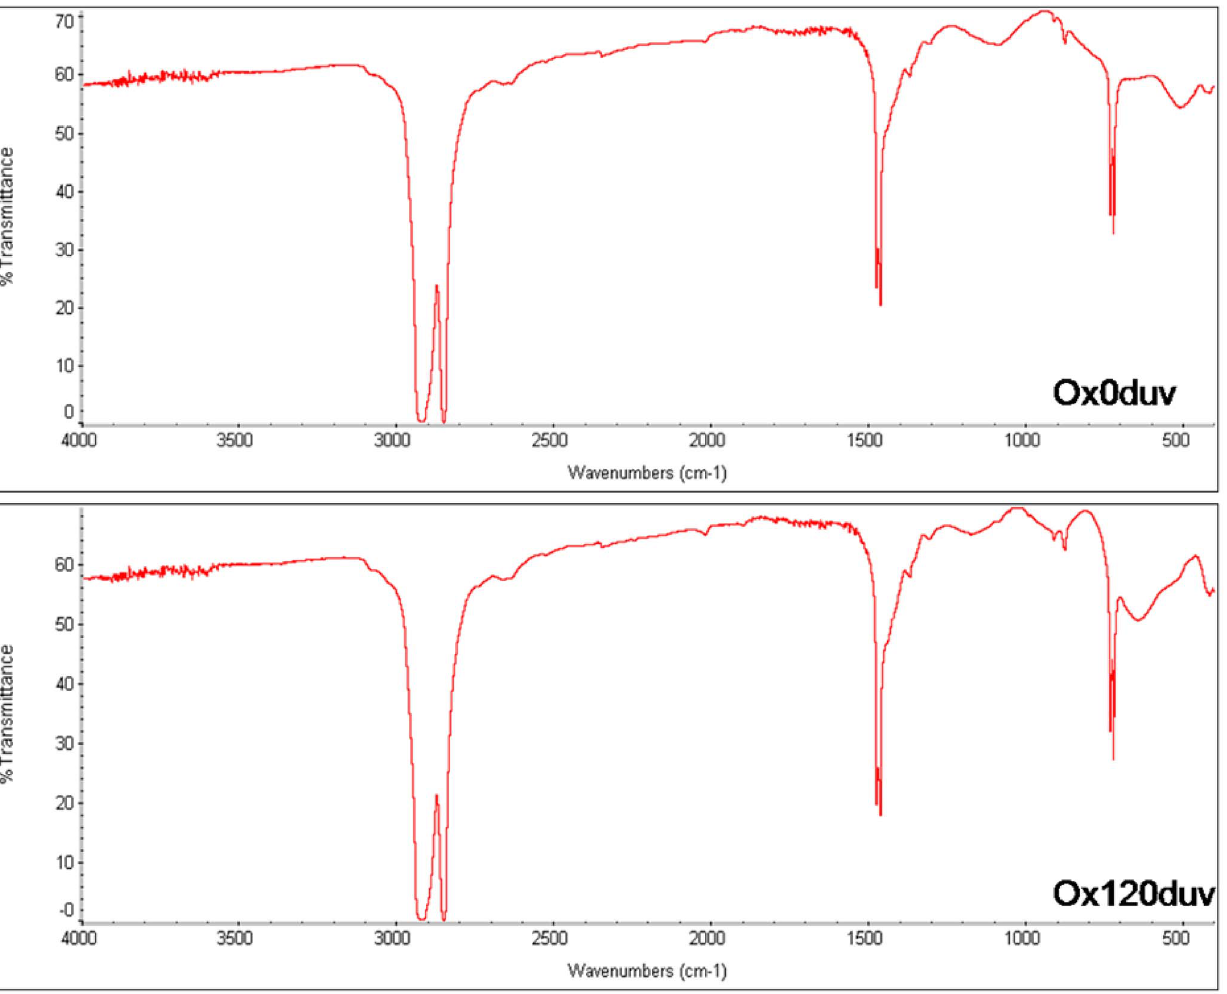
Figure 2. Spectrum of Fourier transform infrared spectroscopy of oxo-biodegradable plastic before (Ox0duv) and after 120 days of sunlight exposure (0x120duv).